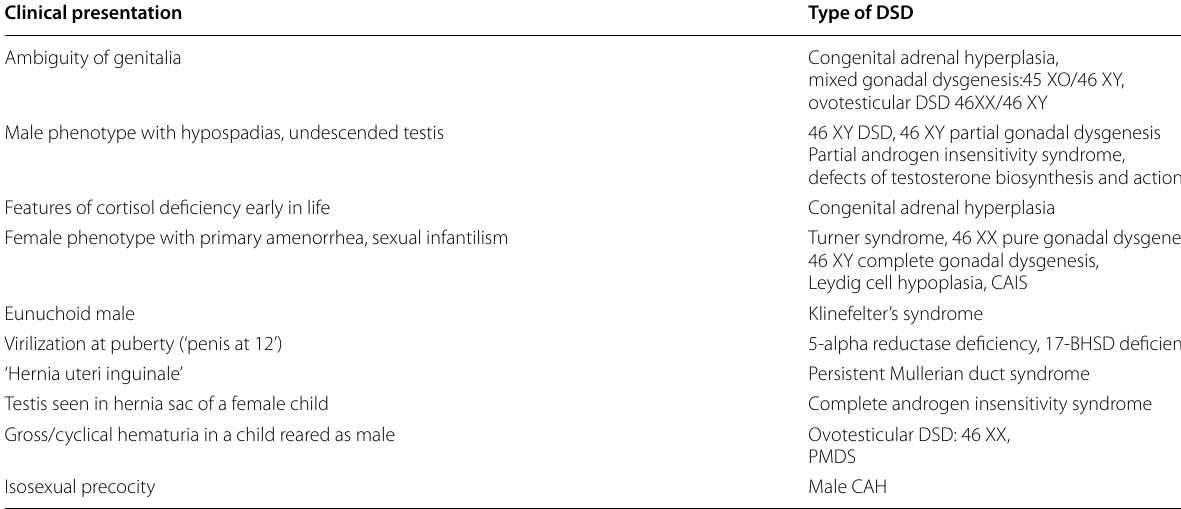
Table 6 The different types of clinical presentation in various DSD Clinical